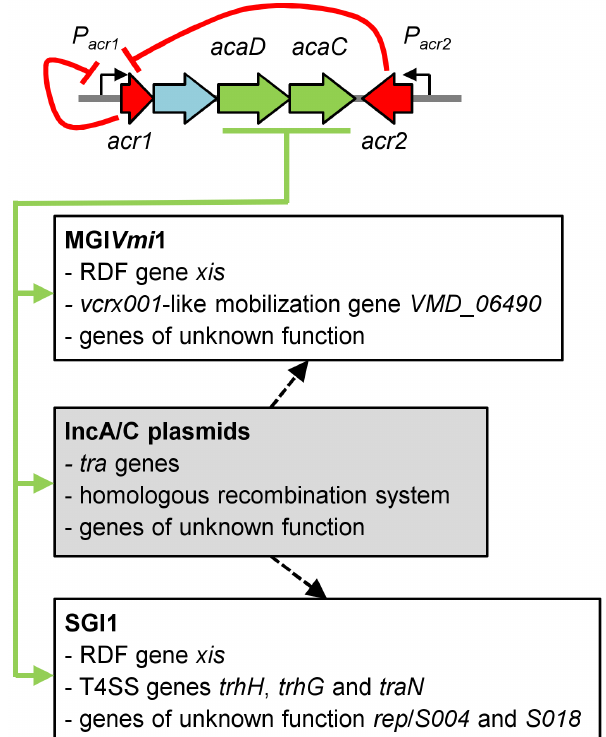
Figure 5. Model of regulation of IncA/C plasmids and interaction with genomic islands. Expression of the master activator complex AcaCD from the promoter of acr1 ( P acr1 ) is directly repressed by Acr1 and Acr2 (red arrows). AcaCD directly activates the expression of the transfer genes of pVCR94, as well as the expression of the bet/exo homologous recombination system and numerous genes of unknown function (green arrows). AcaCD triggered the excision of SGI1 and MGI Vmi 1 by directly activating the expression of the RDF genes xis . AcaCD activates the expression of the vcrx001 -like mobilization gene and other genes of unknown function in MGI Vmi 1. AcaCD also activates the expression of three genes coding for putative component of type IV secretion system (T4SS), as well as genes of unknown function such as S004 , rep and S018 in SGI1. IncA/C plasmids likely provide additional functions for genomic islands dissemination such as oriT recognition and processing or formation of the mating pore (black hatched arrows). Genes are color-coded as in Figure